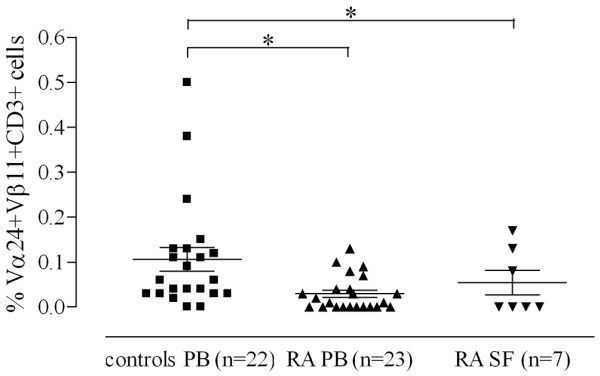
Frequency of natural killer T (NKT) cells in rheumatoid arthritis (RA) patients and healthy control individuals. NKT cell frequency in freshly isolated peripheral blood (PB) mononuclear cells from 22 healthy control individuals and 23 RA patients, and in synovial fluid (SF) mononuclear cells from seven RA patients was determined by flow cytometry. Cells were stained with anti-Vα24, anti-Vβ11 and anti-CD3 monoclonal antibody. Error bars indicate the standard error of the mean. *P < 0.01.